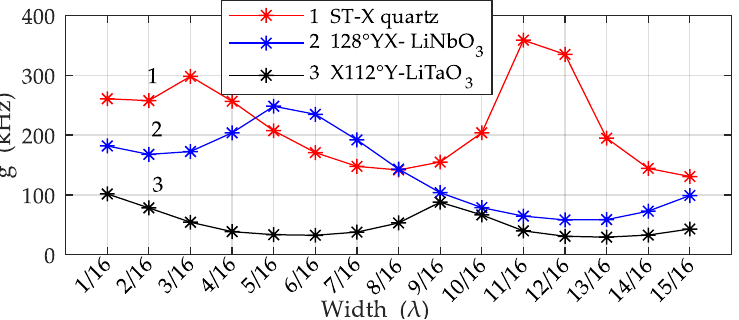
Figure 7. SAW gyroscopic effects of three piezoelectric substrates when a = 1 × 10 − 2 .